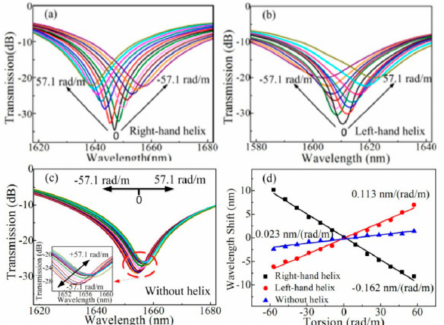
Figure 36. Resonant wavelength shifts for ( a ) right-hand; and ( b ) left-handed pre-twisted LPFG; and